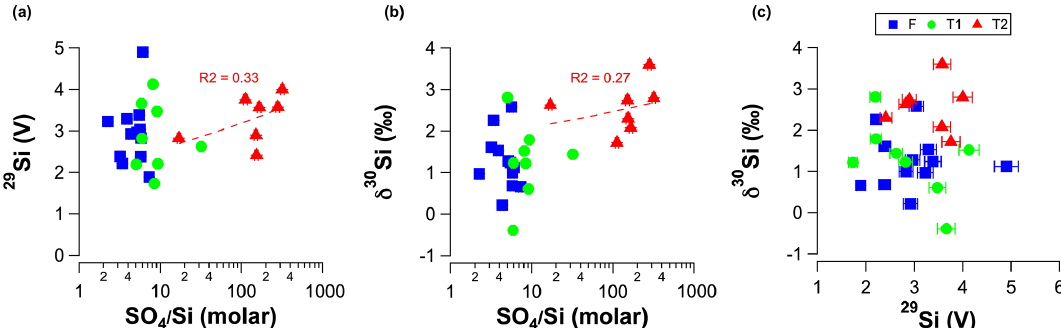
Figure A2. Linear plots for RI groundwater samples showing (a) signal intensity for 29 Si measured during MC-ICP-MS measurements (be- fore dilution to match bracketing standards) as a function of molar SO 4 / Si ratios. (b) δ 30 Si as a function of molar SO 4 / Si ratios and (c) δ 30 Si as a function of signal intensity for 29 Si measured during MC-ICP-MS measurements (before dilution to match bracketing standards). The dashed red lines in panels (a) and (b) show the regression lines for the T2 groundwater.